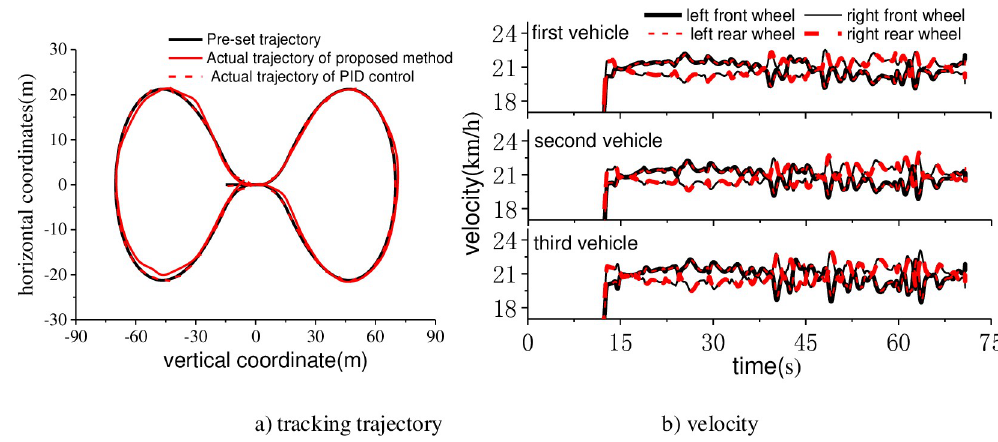
Fig 9. The comparison of pre-set and motion trajectory and the velocity of each wheel.